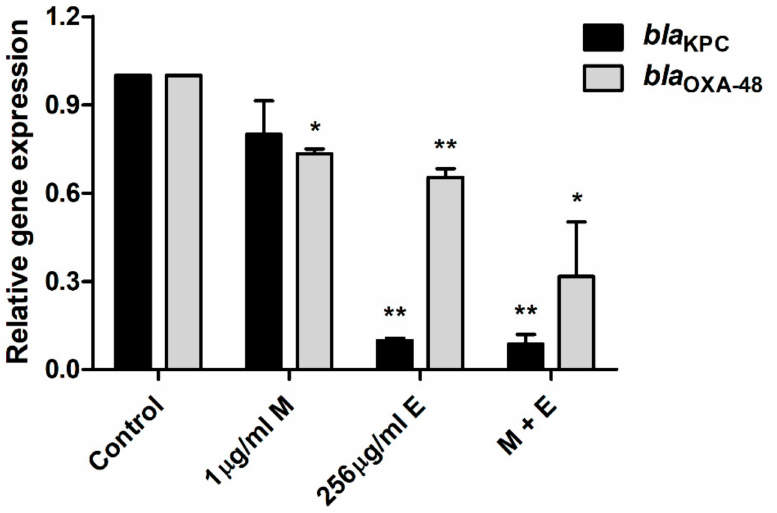
Figure 4. Transcriptional changes in the carbapenemase-related E. coli genes. After treatment with equol alone (256 µ g/mL), meropenem alone (1 µ g/mL), and the combination of 1 µ g/mL of meropenem plus 256 µ g/mL of equol, qPCR analysis of bla KPC and bla OXA-48 genes in E. coli KBN12P05816 was performed. 16SrRNA was used to normalize the transcriptional levels of the target genes. The expression levels of the genes are expressed as fold-changes compared to the control and analyzed using the Student’s t -test. The error bars represent the means and standard deviations (SDs). Asterisks (*) indicate statistically significant differences (* p < 0.05 and ** p < 0.01) from the